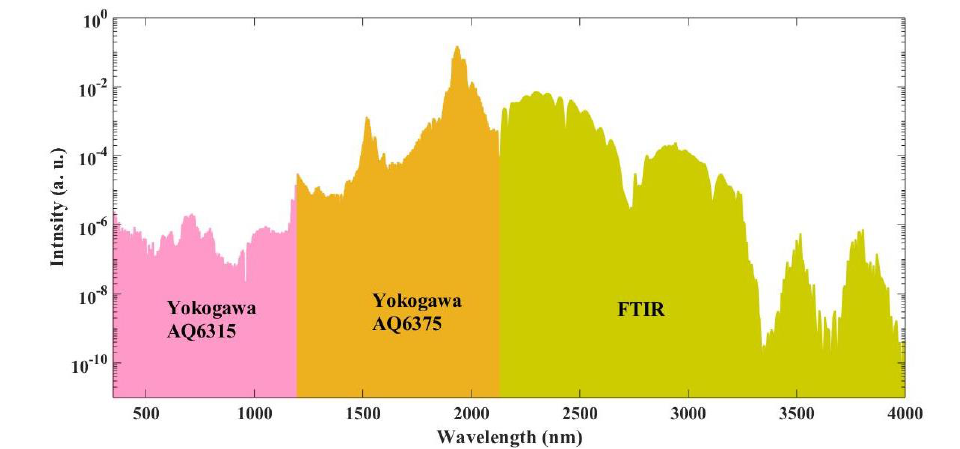
Figure 3. Recorded spectrum of the generated SC in 3-mm YAG.